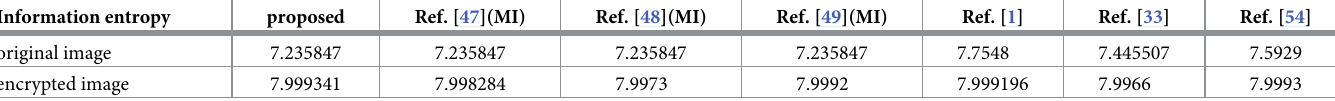
Table 13. Information entropy comparison